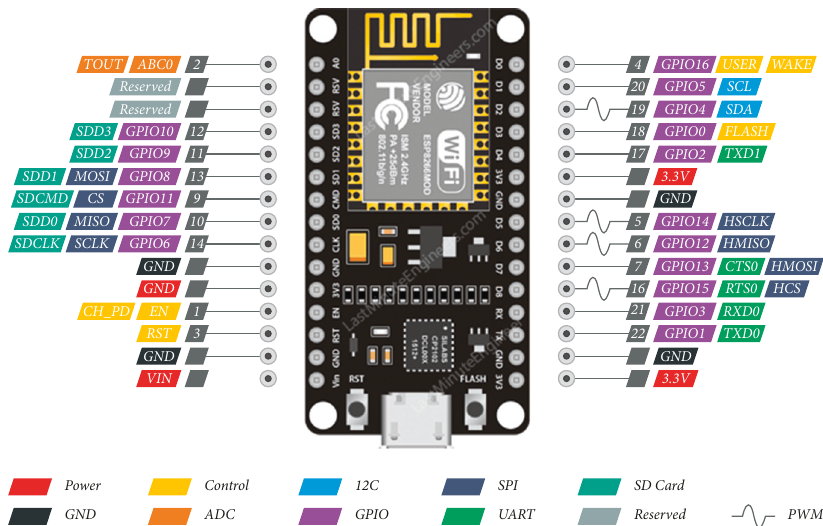
Figure 2: E8266 node microcontroller unit pinout SP (as adopted from SP